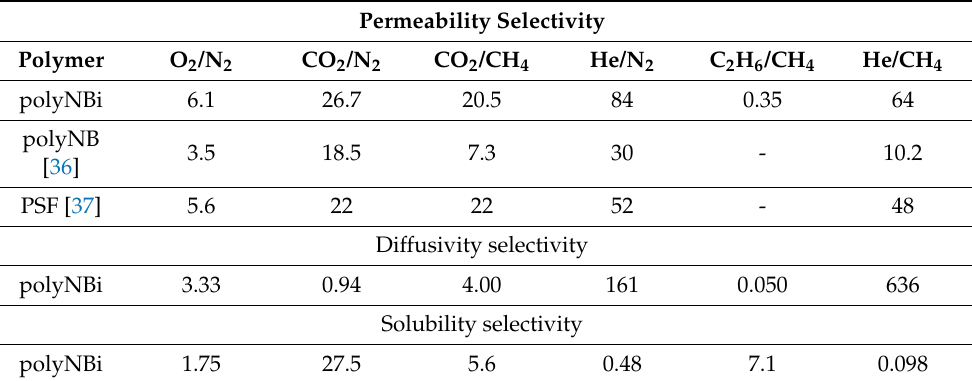
Table 4. Selectivities of separation for different pairs of gases for polyNBi and polyNB. Permeability